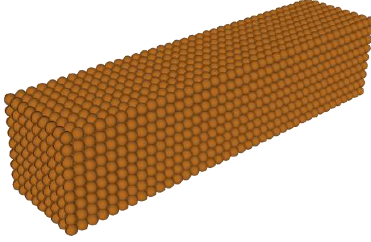
Figure 2. Array of dipoles constructing the target geometry, a single